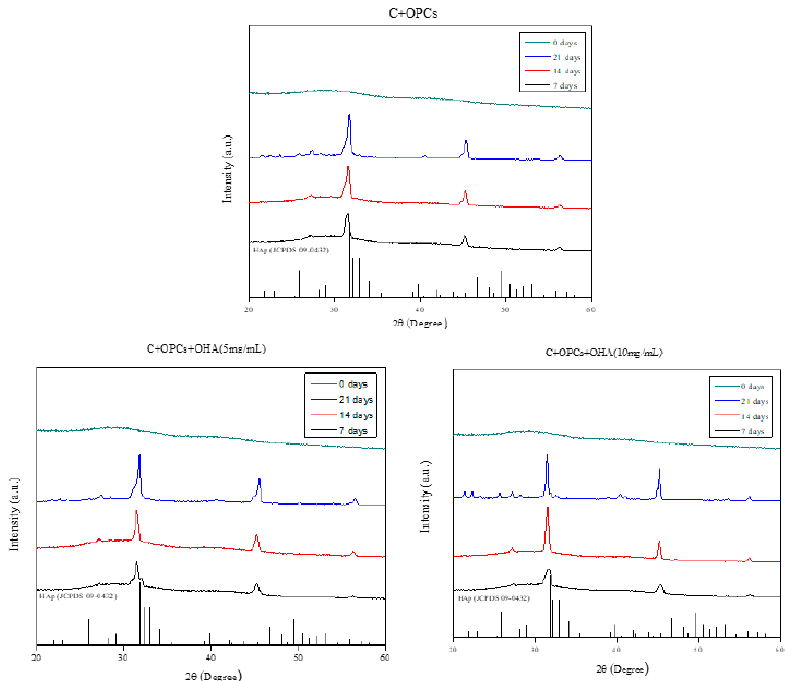
Figure 8. XRD analysis of scaffolds with different concentrations of OHA (0, 5, and 10 mg/mL) immersed in simulated body fluid for 0, 7, 14, and 21 days.